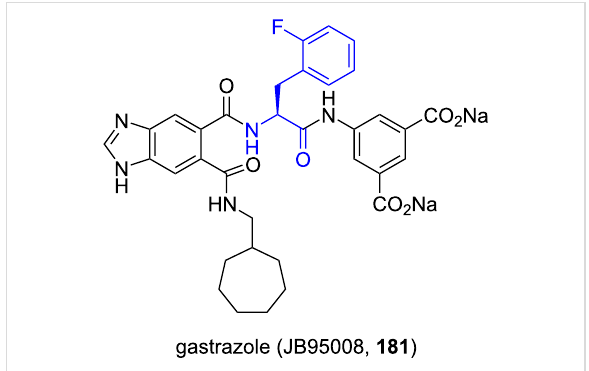
Figure 4: Structure of gastrazole (JB95008, 181 ), a CCK2 receptor antagonist.